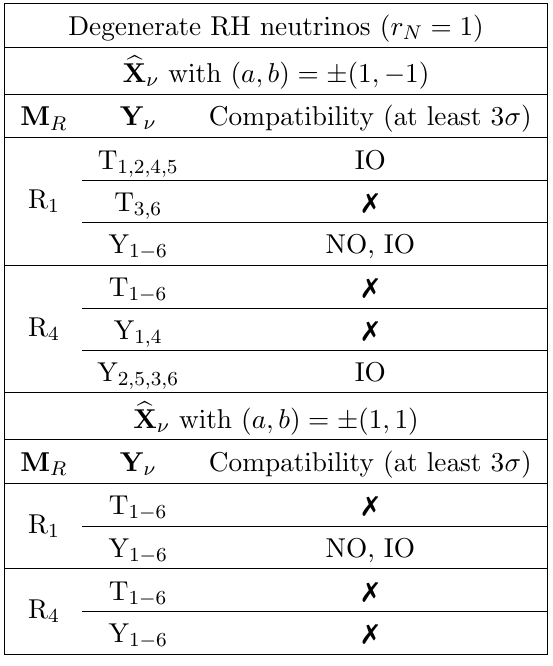
Table 6 . Compatibility summary for the 2RHNSM in presence of the remnant CP symmetry de(cid:12)ned in eqs. (2.13) and (2.14). All cases with Y (cid:23) of the type Y 1 (cid:0) 6 or T 1 (cid:0) 6 , M R of the forms R 1 ; 4 , and degenerate heavy Majorana neutrinos are indicated. For b X (cid:23) with ( a; b ) = (cid:6) (1 ; (cid:0) 1) the matrix O is unconstrained, while for b X (cid:23) with ( a; b ) = (cid:6) (1 ; 1) it is restrained to be of the type O I . For completeness, the combinations (R 1 ,Y 1 (cid:0) 6 ) with ( a; b ) = (cid:6) (1 ; (cid:0) 1) have been included